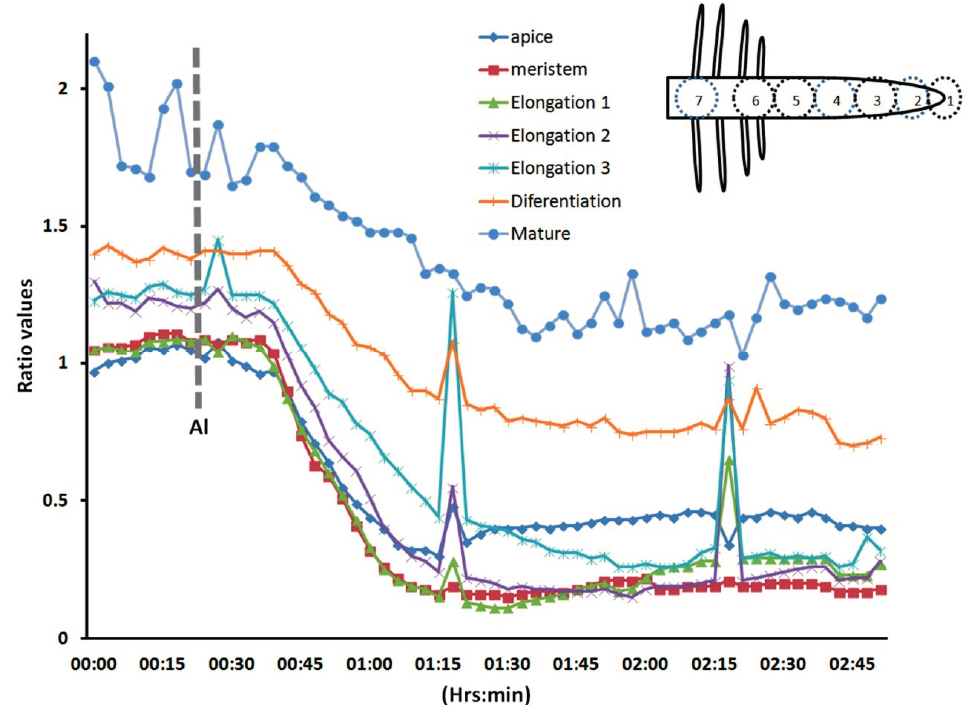
Figure 6. Different regions of the roots respond with a similar pattern, but the elongation region exhibits the most dramatic change. Different regions of Arabidopsis roots treated with 1 mM Al were evaluated for changes in intracellular H 2 O 2 levels (see inset). Note that all the regions responded at the same time, but with a different strength. 1 = apical, 2 = meristem, 3 = elongation 1, 4 = elongation 2, 5 = elongation 3, 6 = differentiation, 7 =